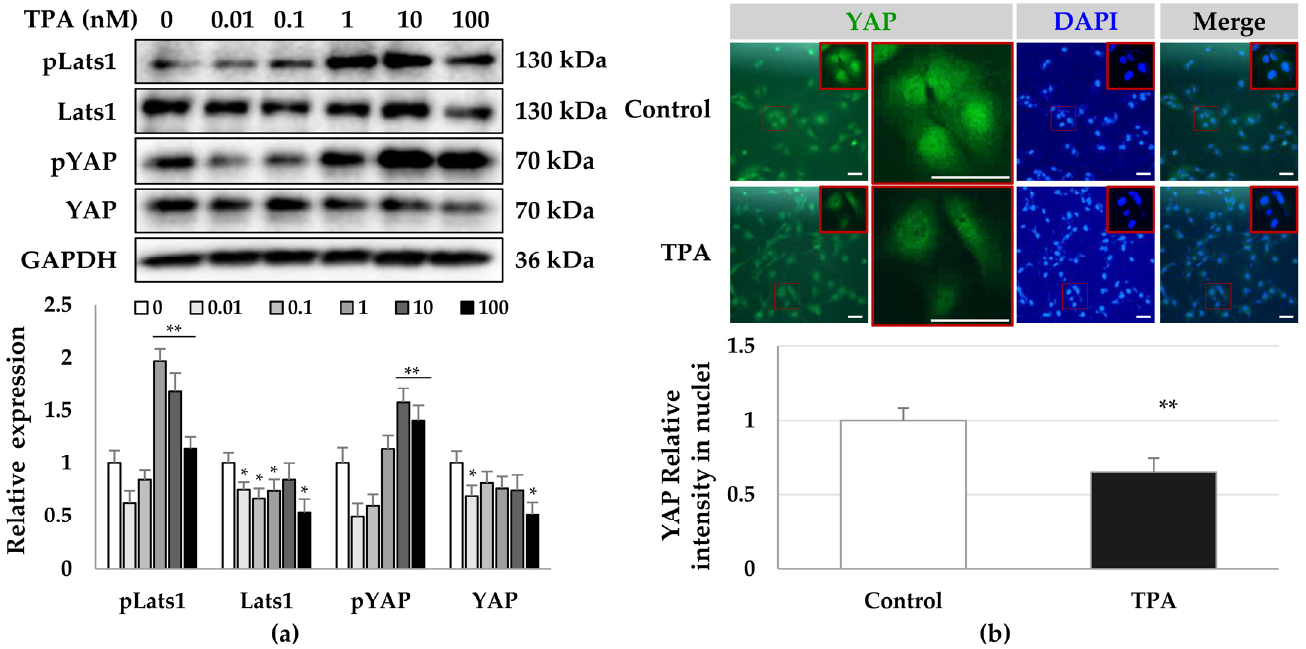
Figure 3. Phosphorylation and cellular distribution of YAP in TPA-treated LX-2 cells. LX-2 cells were treated with TPA (0.01–100 nM) for 24 h. The phosphorylation and cellular distribution of YAP were detected using immunoblotting and immunocytochemistry, respectively, in LX-2 cells treated with 10 nM TPA for 24 h. ( a ) Phosphorylation of LATS1 and YAP in LX-2 cells. The intensity of protein expression was quantified using densitometry with Image J and its relative expression was normalized against that of GAPDH. Data are presented as the mean ± SD of three independent experiments. * p ≤ 0.05 and ** p ≤ 0.01. ( b ) Cellular distribution of YAP in TPA-treated LX-2 cells. The nuclear fluorescence intensity of YAP was quantified using densitometry with Image J. Nuclear fluorescence intensity was analyzed from three random fields, with over 30 cells counted per field. Data are presented as the mean ± SD of three independent experiments. ** p ≤ 0.01. Scale bar, 20 µ m.